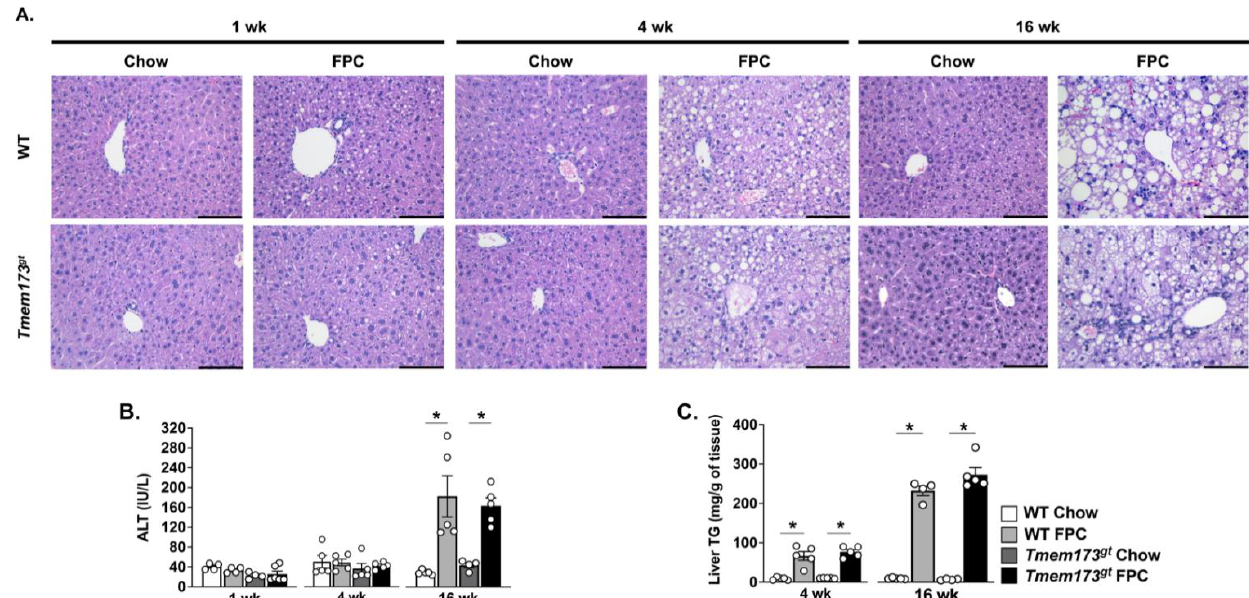
Figure 3. Liver steatosis and injury in WT and STING-deficient livers during short- and long- term chow and FPC feeding. ( A ) Representative photomicrographs of H&E stained liver from WT and Tmem173 gt mice at 1 wk, 4 wk, and 16 wk post-FPC feeding. Control chow histology not shown, showed no pathological differences. ( B ) ALT levels at 1 wk, 4 wk, and 16 wk and ( C ) liver triglyceride levels for 4 wk and 16 wk in WT and Tmem173 gt mice fed chow or FPC. Graphs represent means ± SEM. * p < 0.05 for each genotype compared to its respective chow